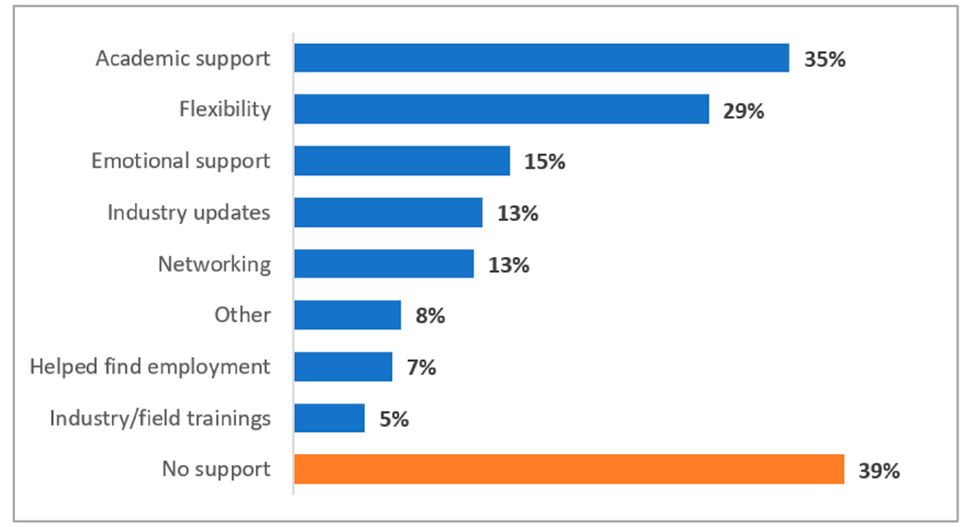
Figure 12. USM support during COVID-19 ( n = 157).